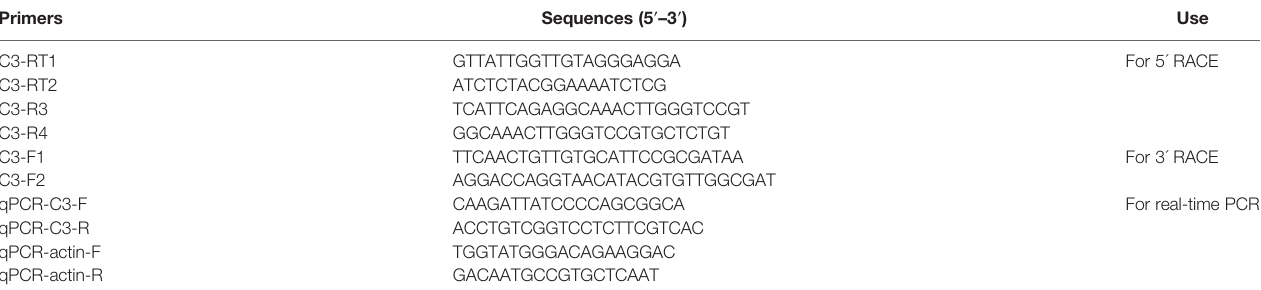
TABLE 1 | Primers used in the present